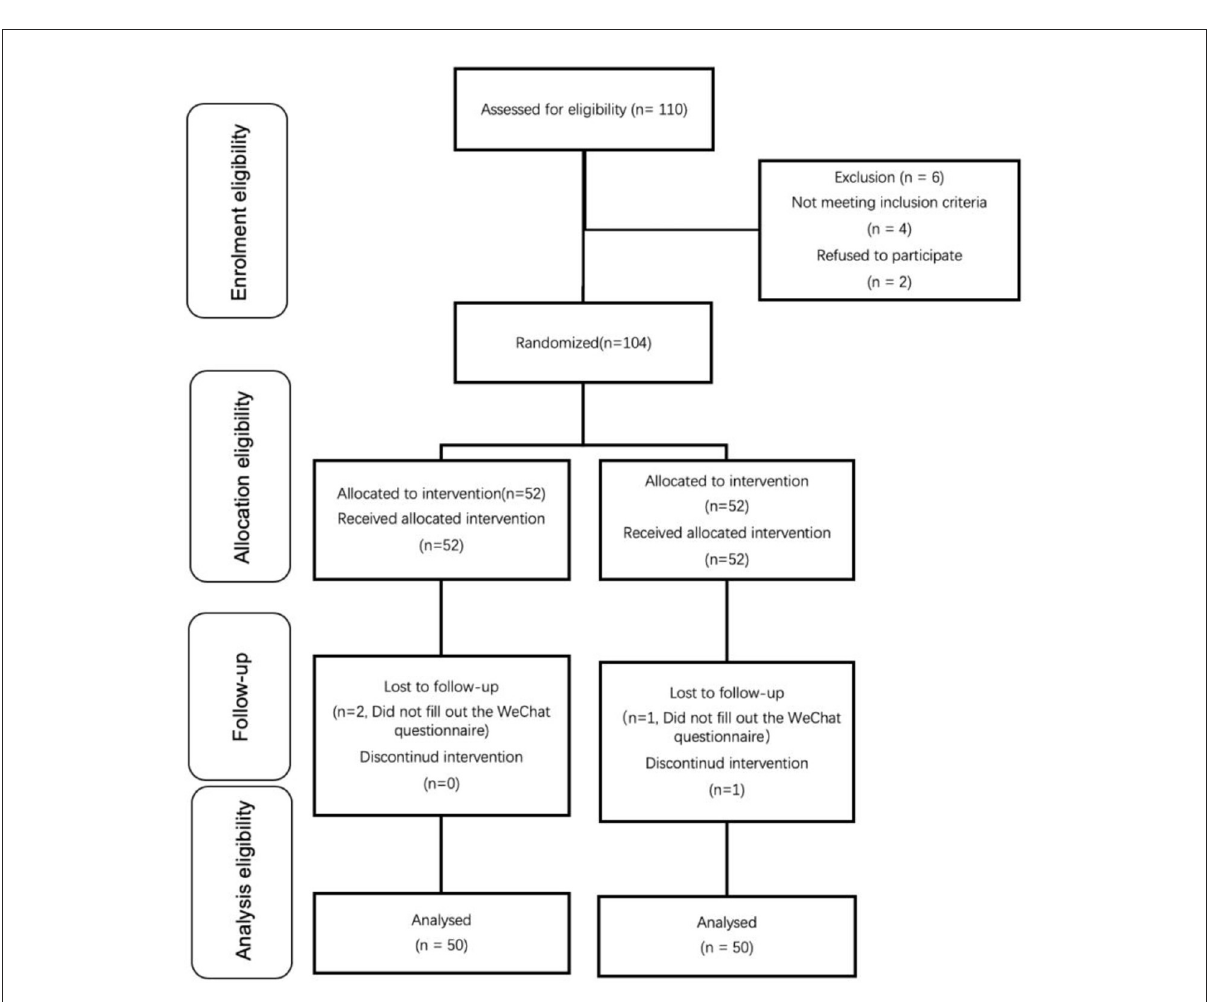
FIGURE1 Patient assignment to study group (randomized) and treatment protocols.